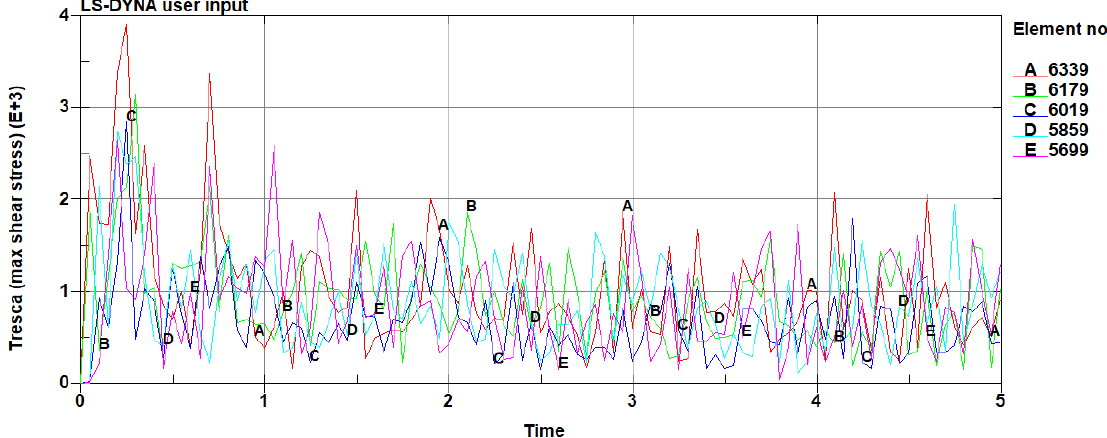
Figure 15. Cloud of maximum shear stress for an elevation 20 m.